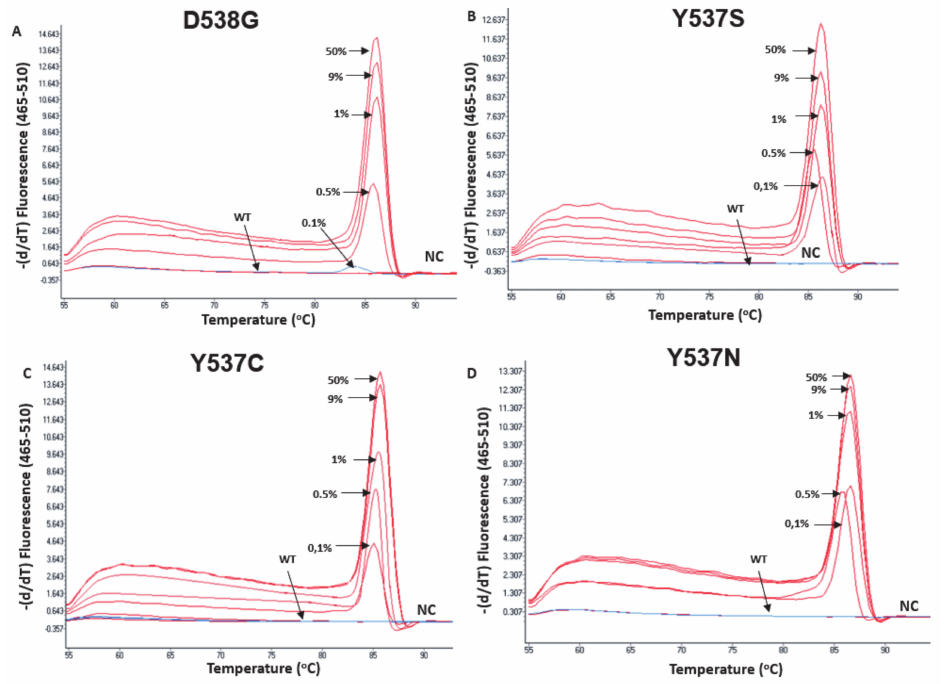
Figure 5. Analytical sensitivity of the ESR1 NAPA assay in samples prepared by mixing known concentrations of mutated synthetic oligos with wtDNA. The mutation allele frequencies (MAFs) tested were 50%, 9%, 1%, 0.5%, 0.1% and 0%. WT: wild type; NC: PCR negative control. ( A ): D538G, ( B ) Y537S, ( C ) Y537C, ( D )